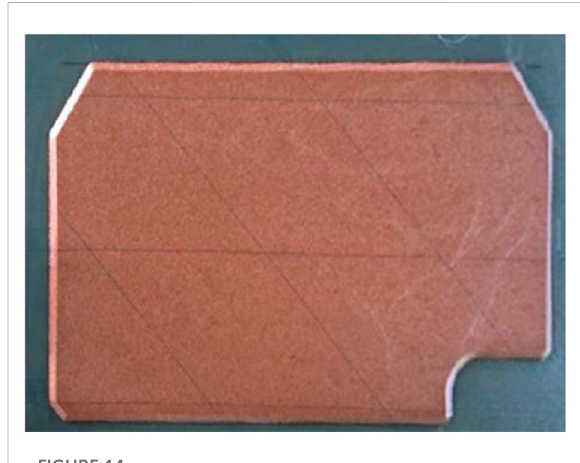
FIGURE 14 The typical sandwich structure of prepreg/PMI foam.